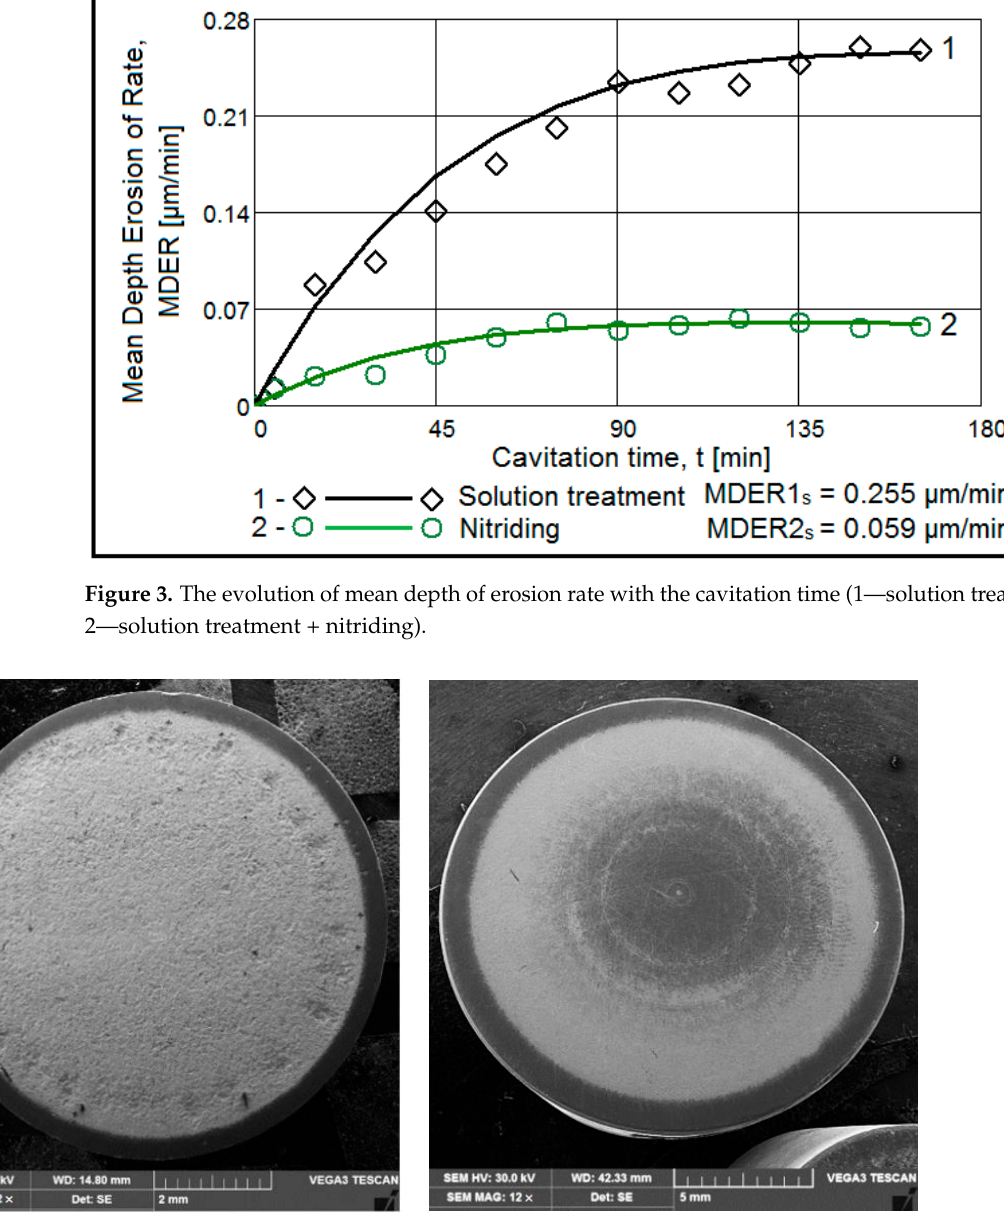
Figure 4. Macrographic images of the surfaces tested for 165 min cavitation time: ( a ) Reference ma- terial (solution-treated); ( b ) Solution-treated followed by nitriding.